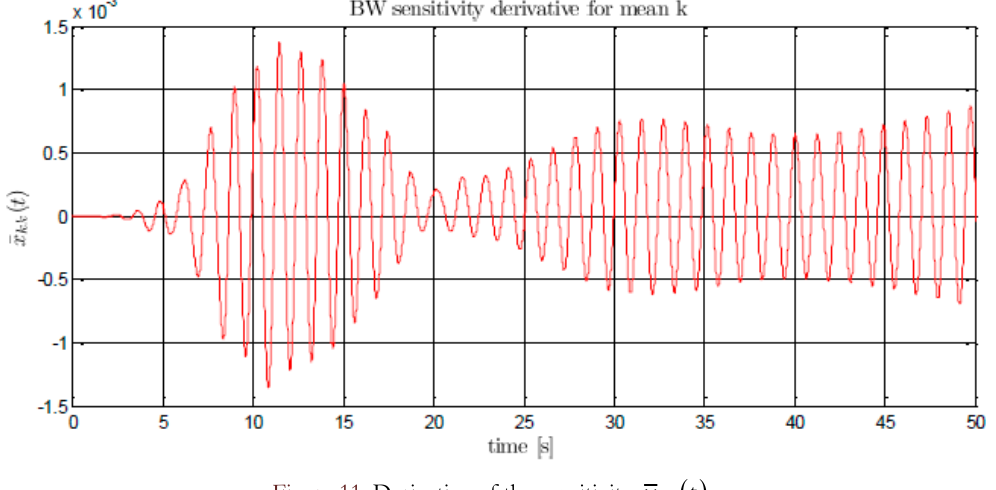
Figure 11: Derivative of the sensitivity